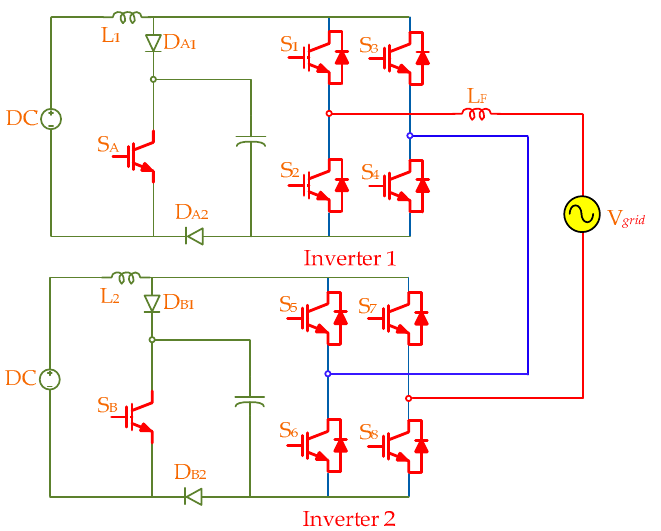
Figure 26. Single phase cascaded H-bridge qSBI topology.